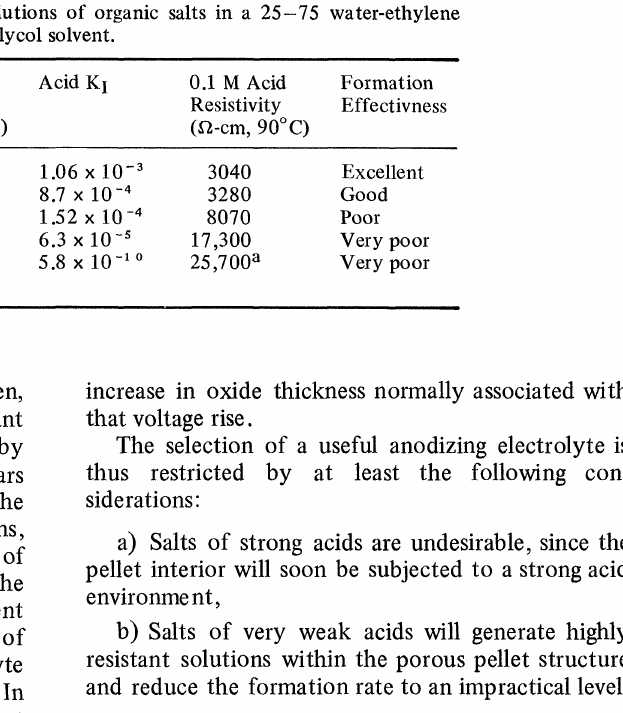
TABLE III Formation effectiveness of 0.02 M solutions of organic salts in a 25-75 water-ethylene glycol